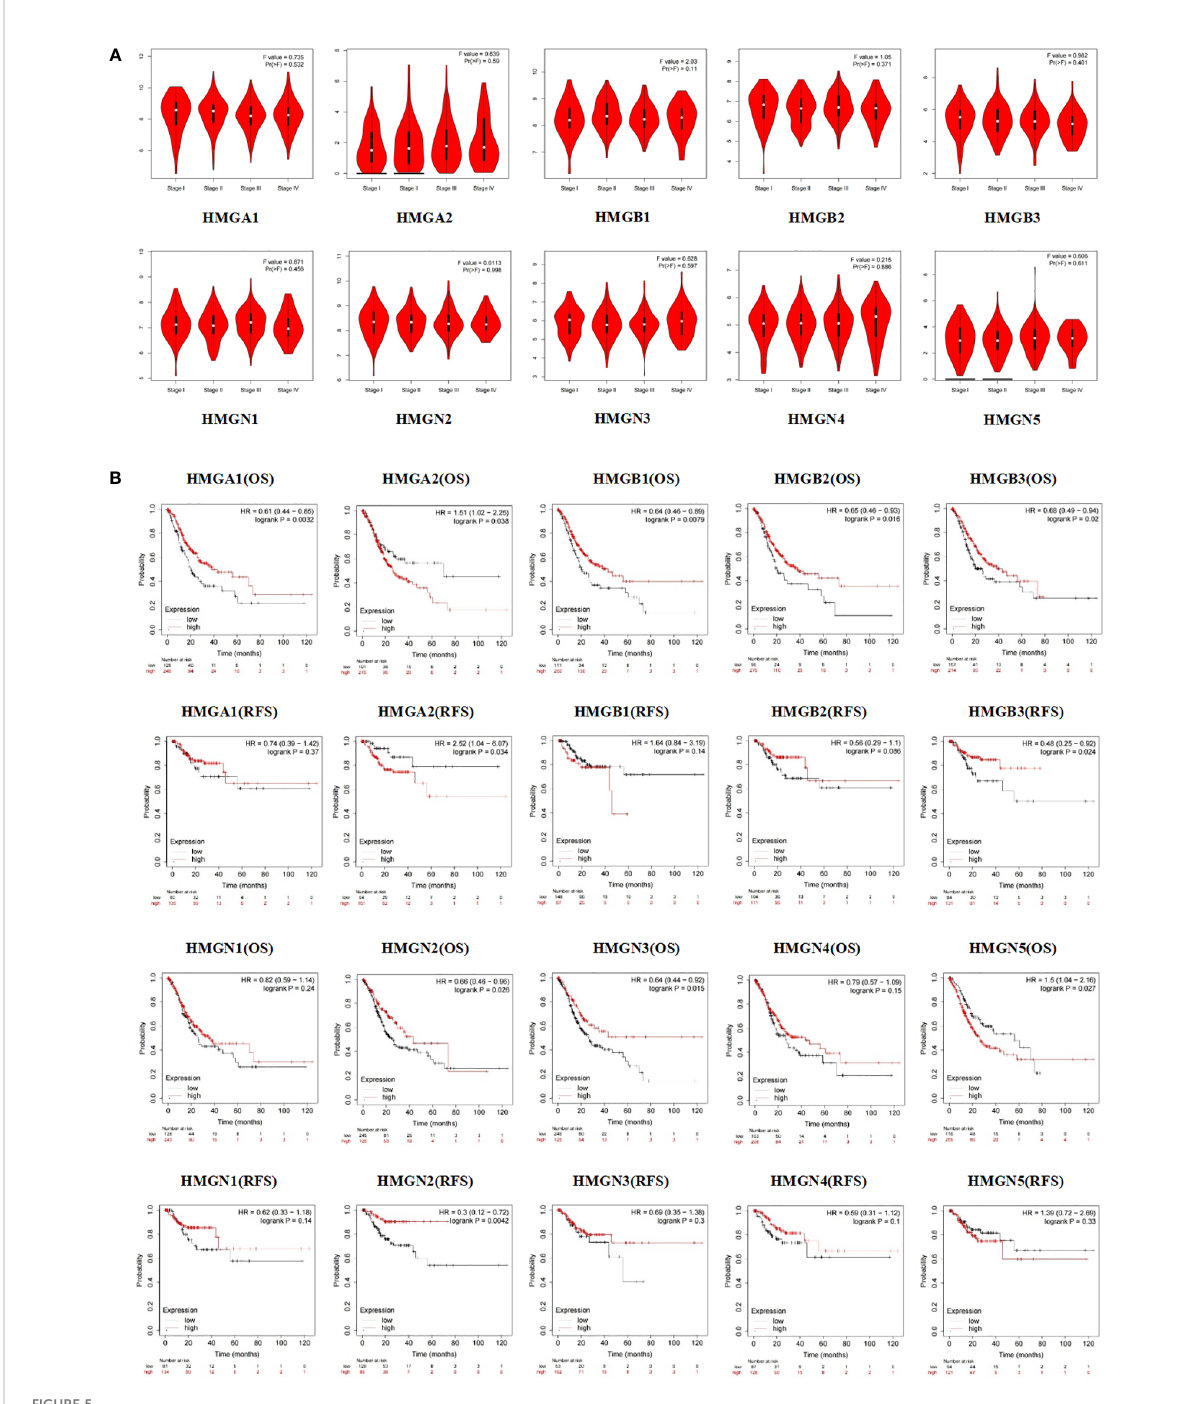
FIGURE 5 (A) Association between HMGs and tumor stage in GC; (B) Effect of HMGs on OS and RFS in